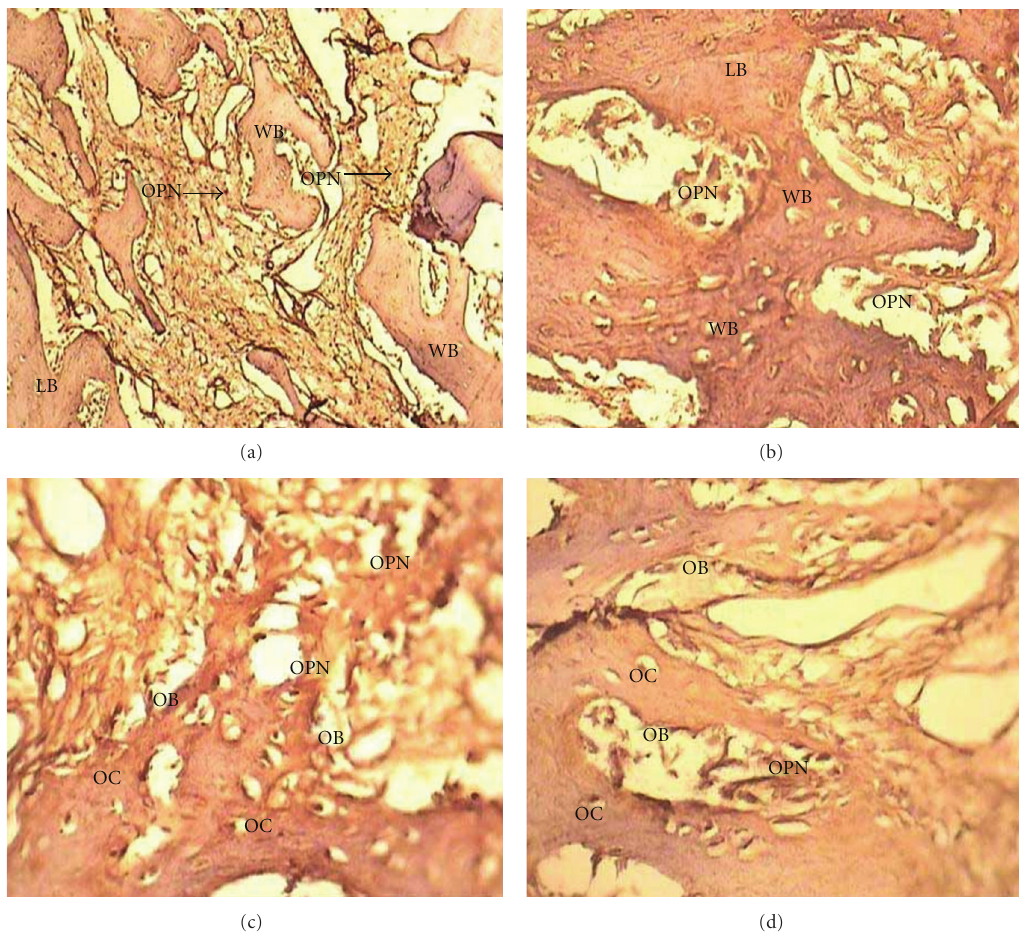
Figure 4: Immunohistochemical views of OPN stain intensity. ((a), magnification × 100) EMD/BC with membrane; ((b), × 400) EMD/BC without membrane; ((c); × 400) GBR group; ((d), × 400) control group. LB: lamellar bone, WB: woven bone, OB: osteoblast, OC: osteoclast, OPN: osteopontin-expressing